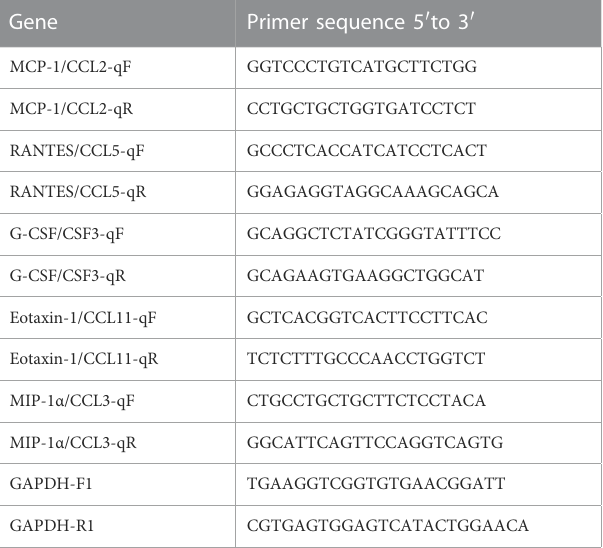
TABLE 1 Sequences of gene-speci fi c primers used for qRT-PCR analysis. Gene Primer sequence 5 ′ to 3